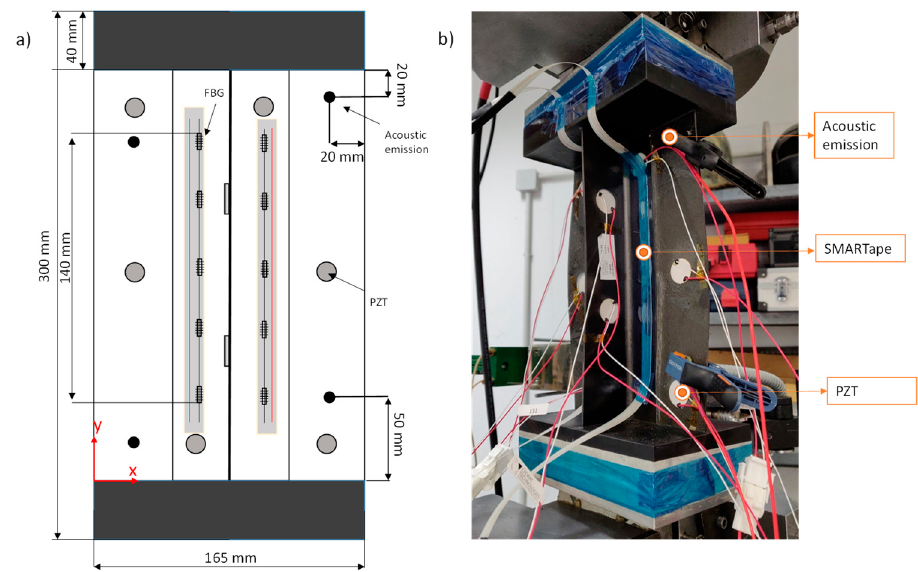
Figure 2. ( a ) Schematic description of the SSP and the sensor positioning, and ( b ) actual test setup.